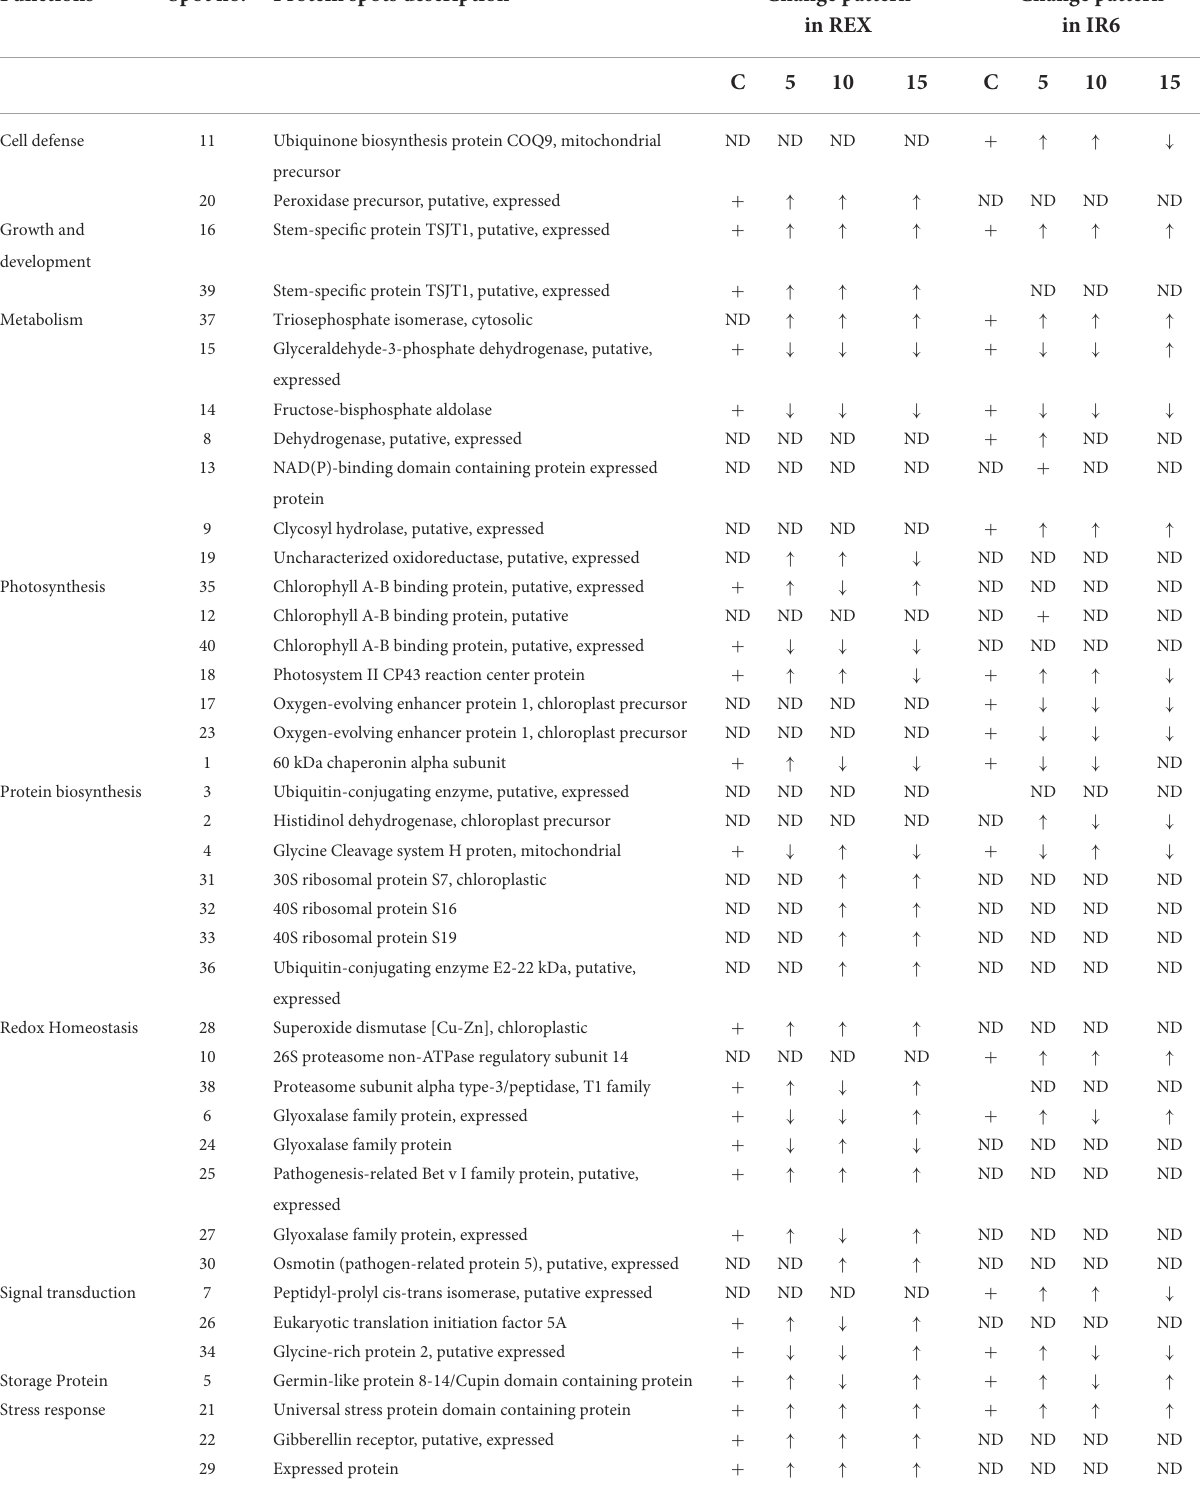
TABLE 2 Functional classification and expression pattern of proteins in rice leaves under different levels of UV-B response. Functions Spot no.